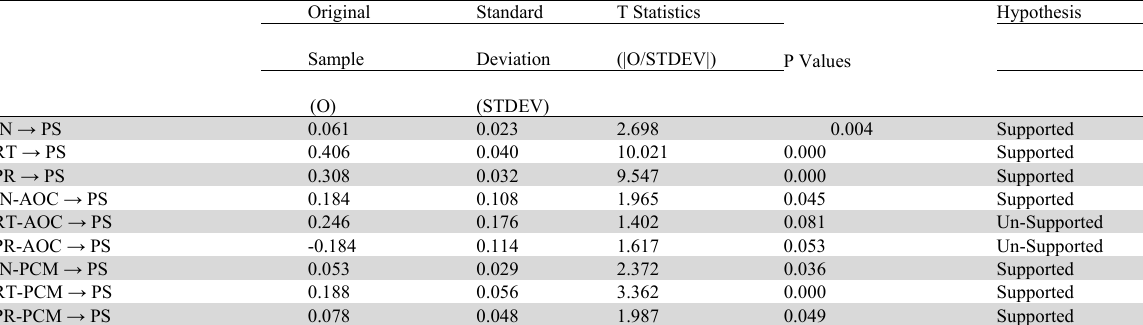
The results of path coefficients